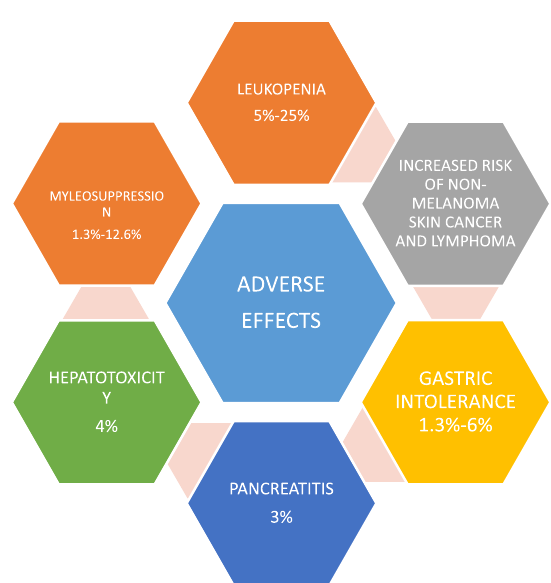
Fig. 1 Side effects of thiopurines in IBD cases (LEUKOPENIA, NON‑MELANOMA SKIN CANCER AND LYMPHOMA, pancreatitis, Gastric intolerance, hepatotoxicity, myelosuppression)